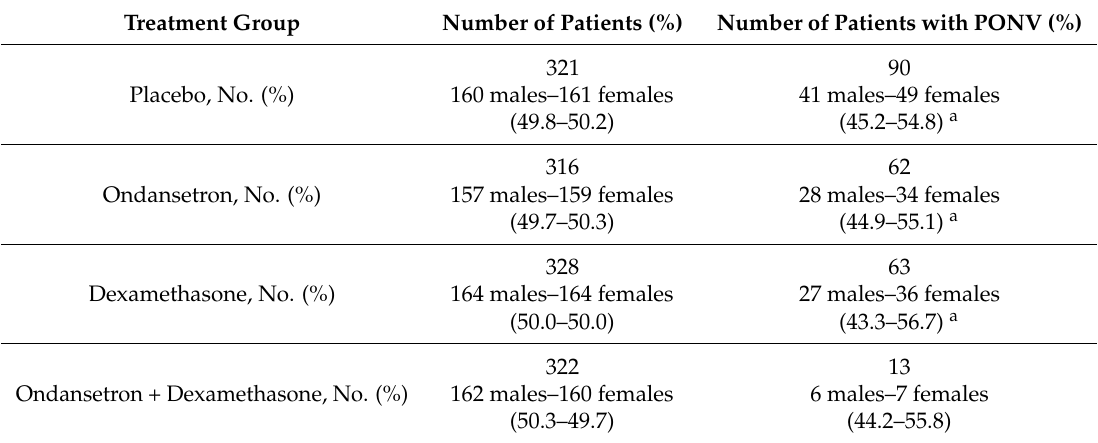
Table 3. Proportion of patients with postoperative nausea and vomiting (PONV) divided by gender. Treatment Group Number of Patients (%) Number of Patients with PONV (%)